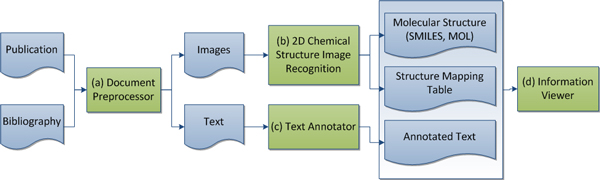
System overview.